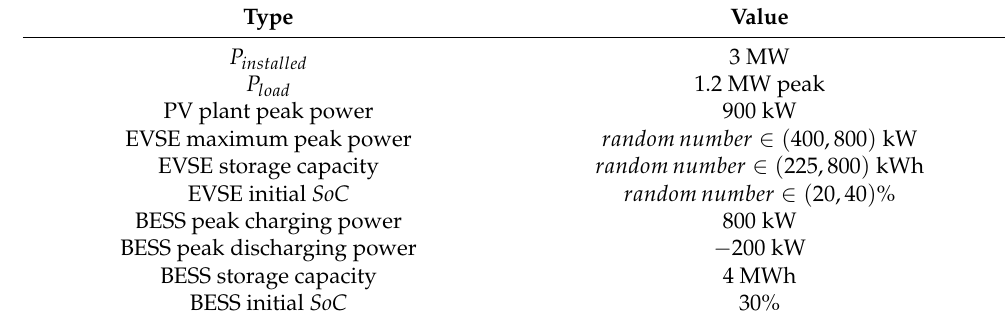
Table 1. Simulation setting.